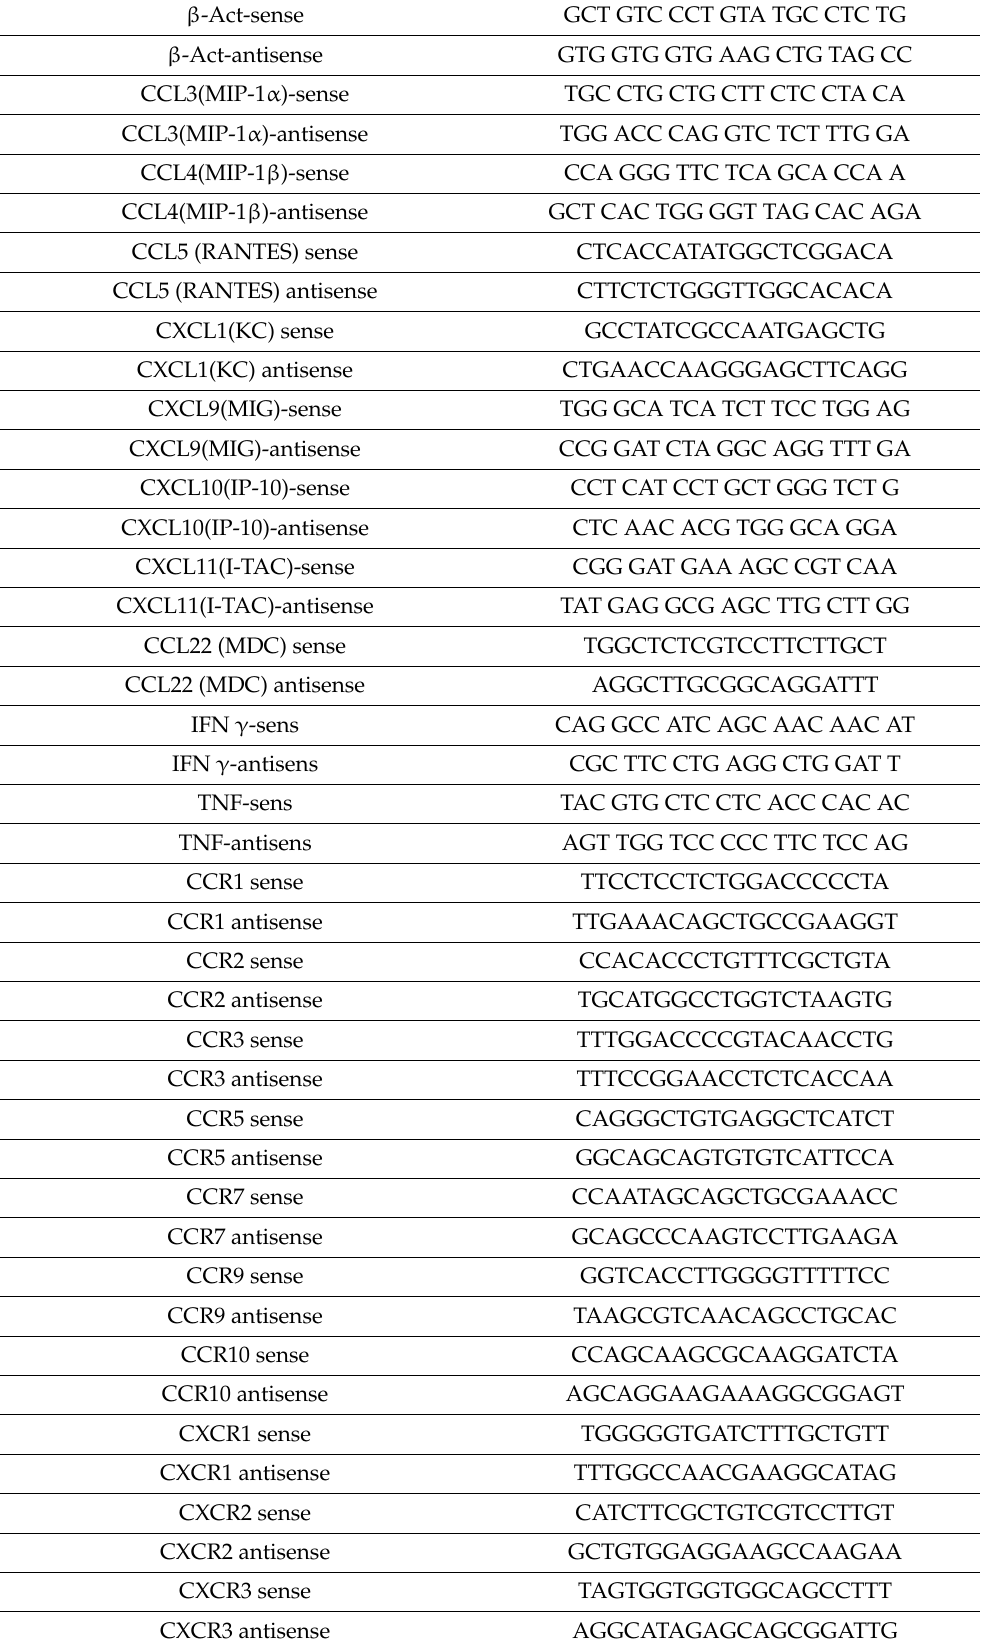
Table 1. Primers used for real-time